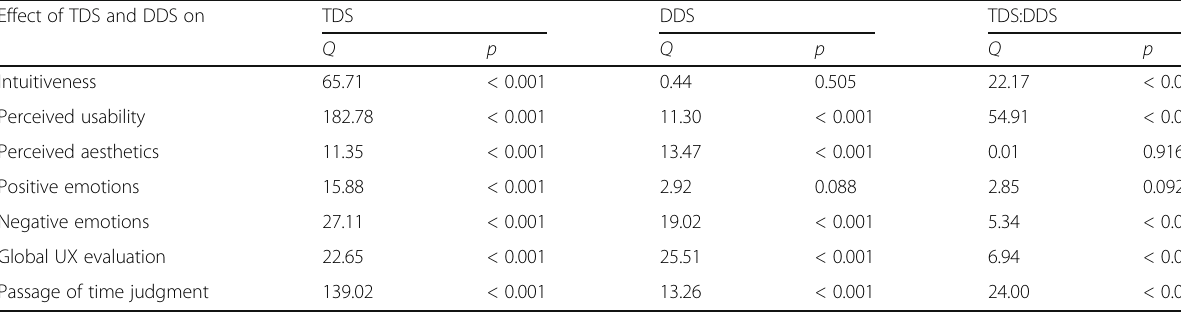
Table 3 Robust tests with the effects of TDS and DDS on intuitiveness and UX dimensions Effect of TDS and DDS